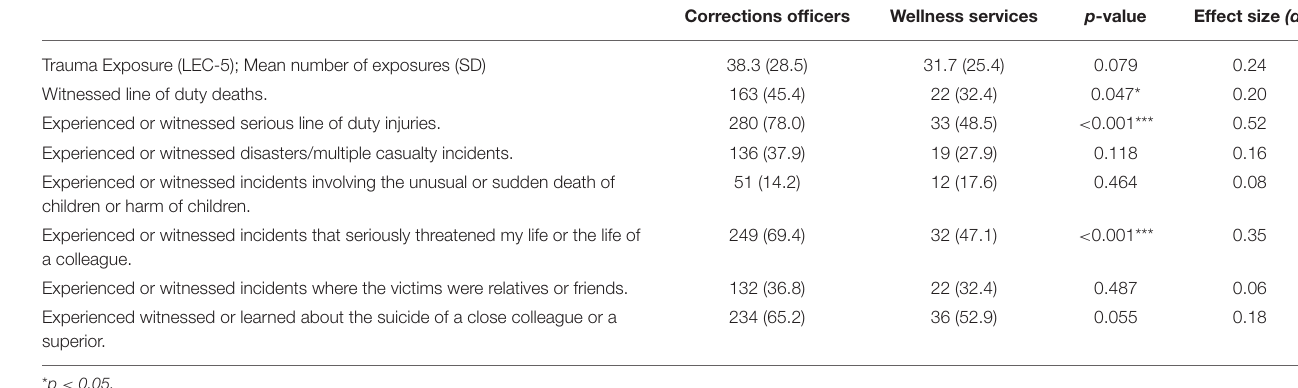
TABLE 2 | PPTE-related comparisons between institutional wellness services and corrections officers.